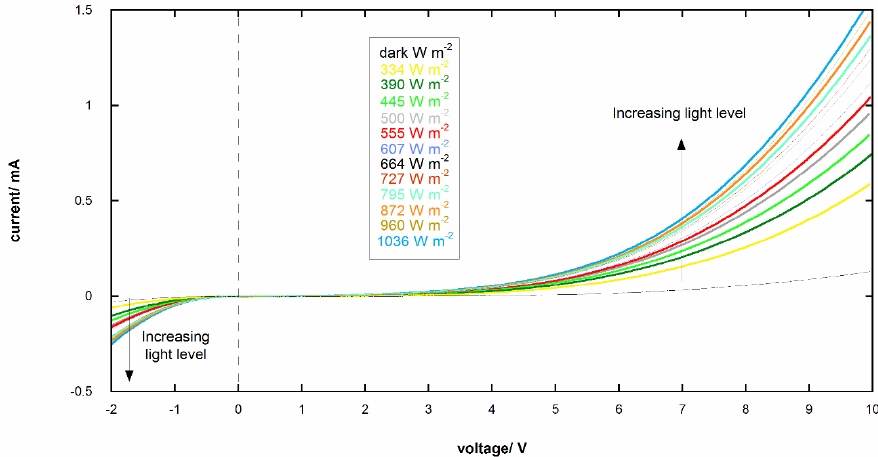
Figure 6. I ‐ V curves of the photoresponsive device under simulated solar light with different irradiation levels in the range 334–1036 W m − 2 and in dark.